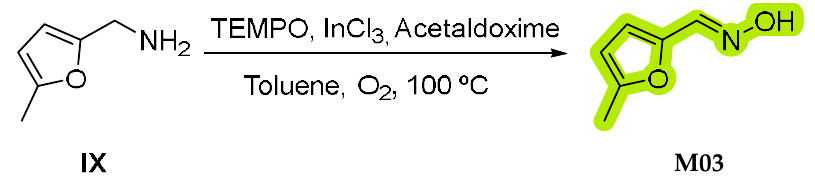
Figure 15. Alternative synthetic route for the preparation of compound M03 . Starting material IX is commercially available.